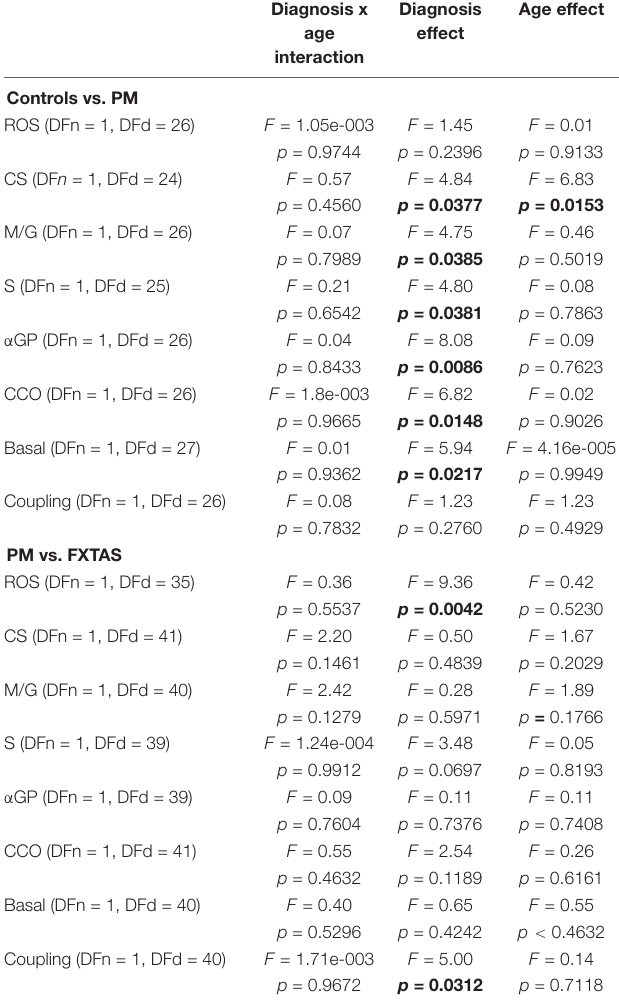
TABLE 2 | Effect of diagnosis, age and diagnosis x age interaction on mitochondrial outcomes evaluated in controls, PM and FXTAS female carriers. Diagnosis x